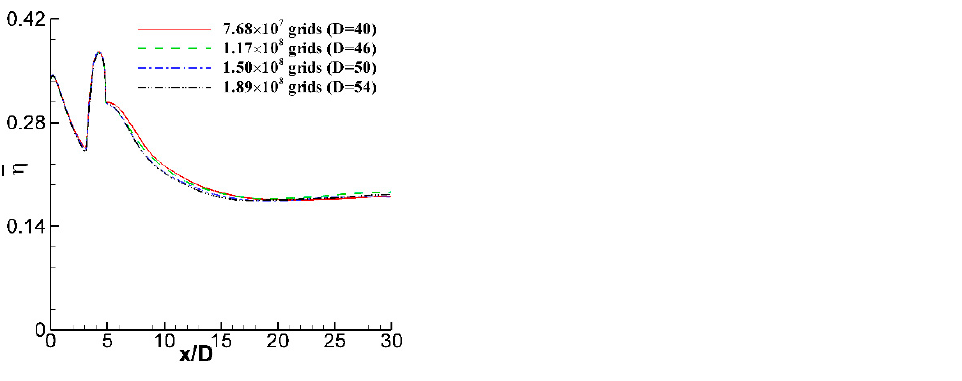
Figure 4. Comparison of the spanwise-averaged film cooling effectiveness 𝜂̅ of Case 2 for four grid numbers.